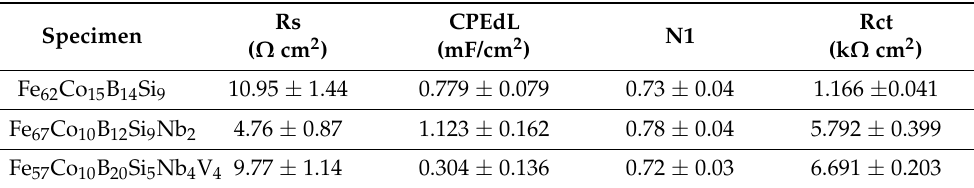
Figure 9. The equivalent electric circuit used to interpret the measured EIS spectra. Table 2. EIS